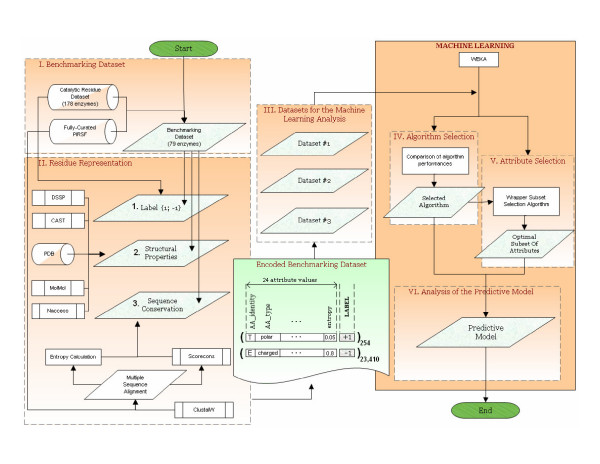
Method overview.